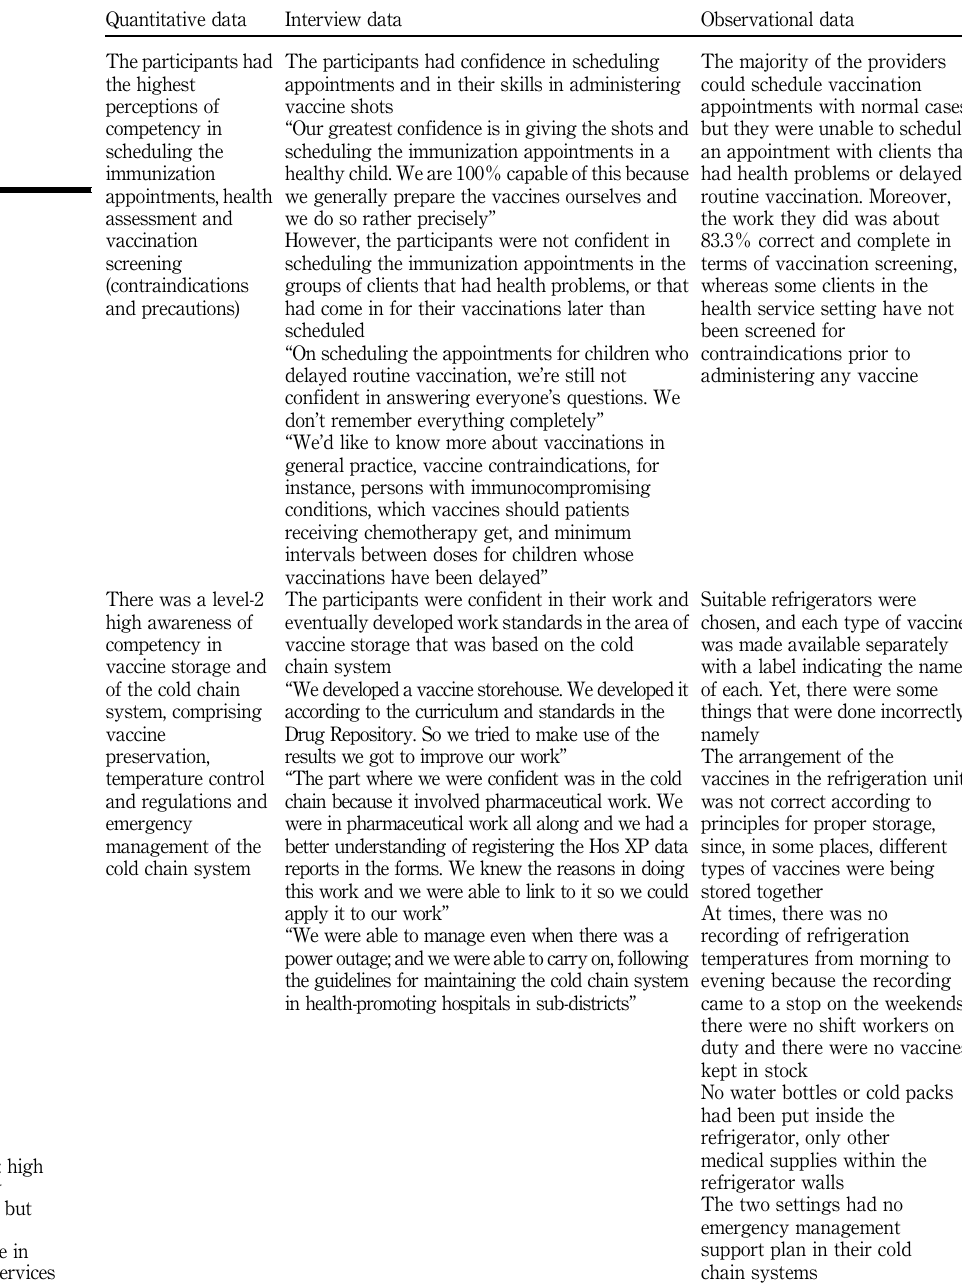
Table IV. Category II: high competency perceptions but incomplete performance in providing